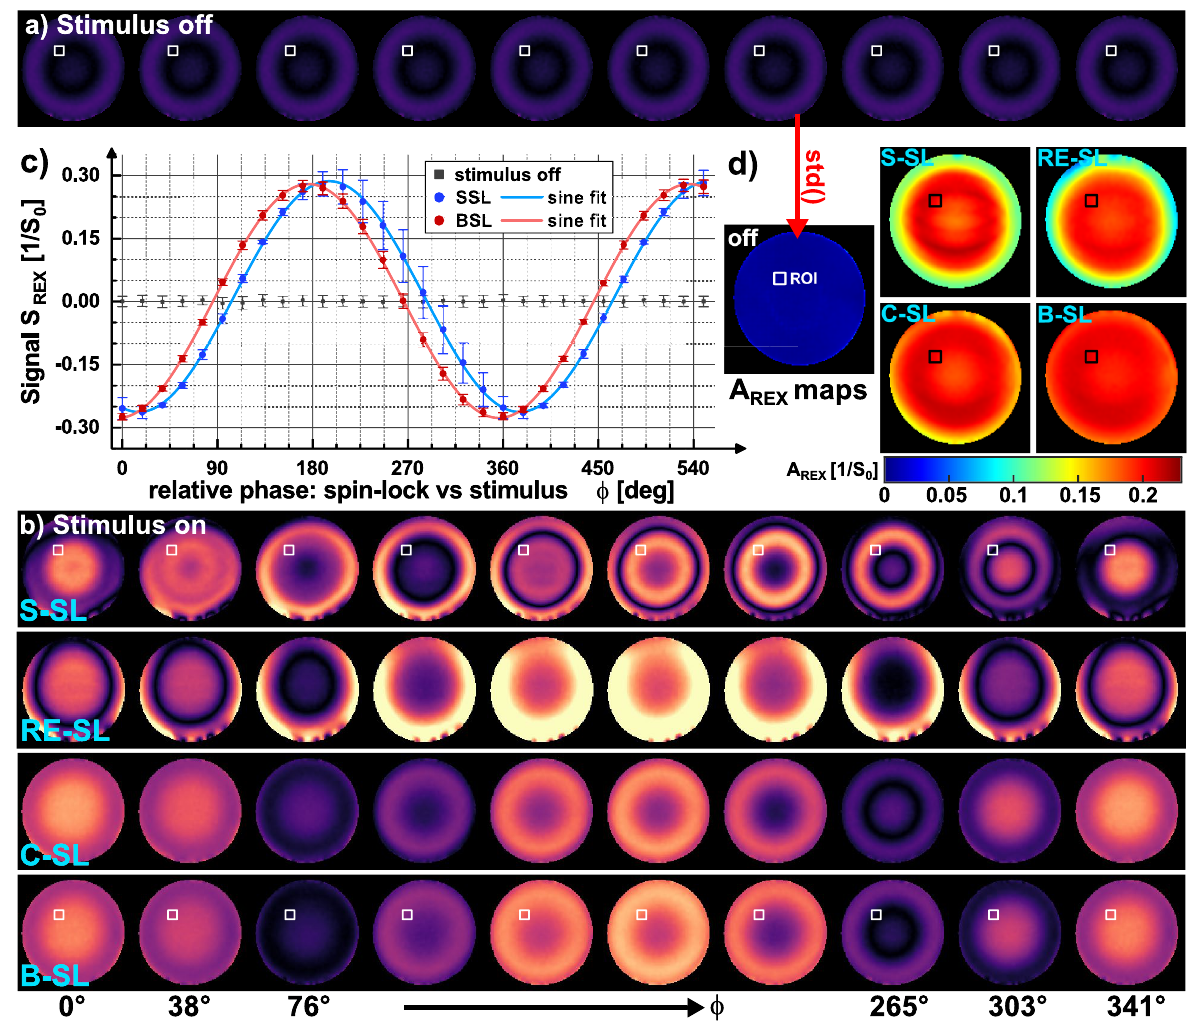
Figure 4. Phantom measurements for feasibility demonstration of the tREX method. ( a ) The reference scans (stimulus off) and ( b ) shows the REX weighted magnitude images (S REX ) for 10 different relative phases between spin-lock pulse and transmitted oscillation. In ( c ), the signal intensity, which is used for A REX calculation, was plotted against the relative phase in a ROI based evaluation exemplary for S-SL and B-SL. In addition, the reference scan results were plotted. The standard deviation calculated pixel-by-pixel from the phase variation is shown in the A REX maps in ( d ). The measurements performed with B-SL show reduced banding artifacts in the S REX images, which is due to the improved compensation of field inhomogeneities. Thus, the A REX map is most homogenous as well. Furthermore, decreasing A REX at the edge of the phantom is visible for S-SL and RE-SL. This correlates with deviations of the B + 1 field (Supplementary Fig. 7). The measurements were performed in an axial tREX slice (Δz = 10 mm, 5 mm thickness). Other sequence parameters were: f SL = f stim = 50 Hz, (cid:31) B stim 0 = 50 nT, FOV = 150 × 150 mm 2 , matrix = 96 ×